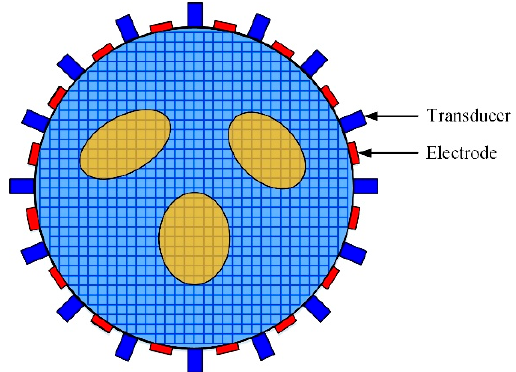
Figure 3. Mesh model of EIT/UT dual-modality imaging.